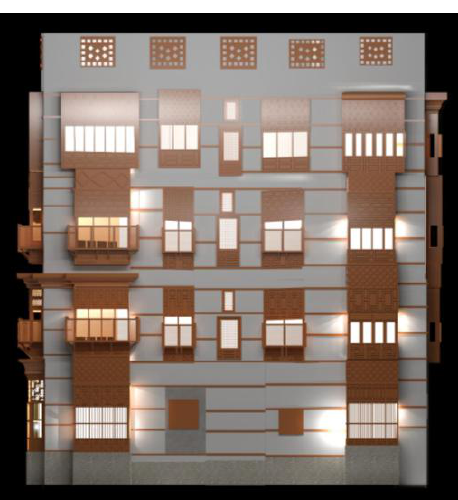
Figure 14. Rendering South Elevation from JHBIM.